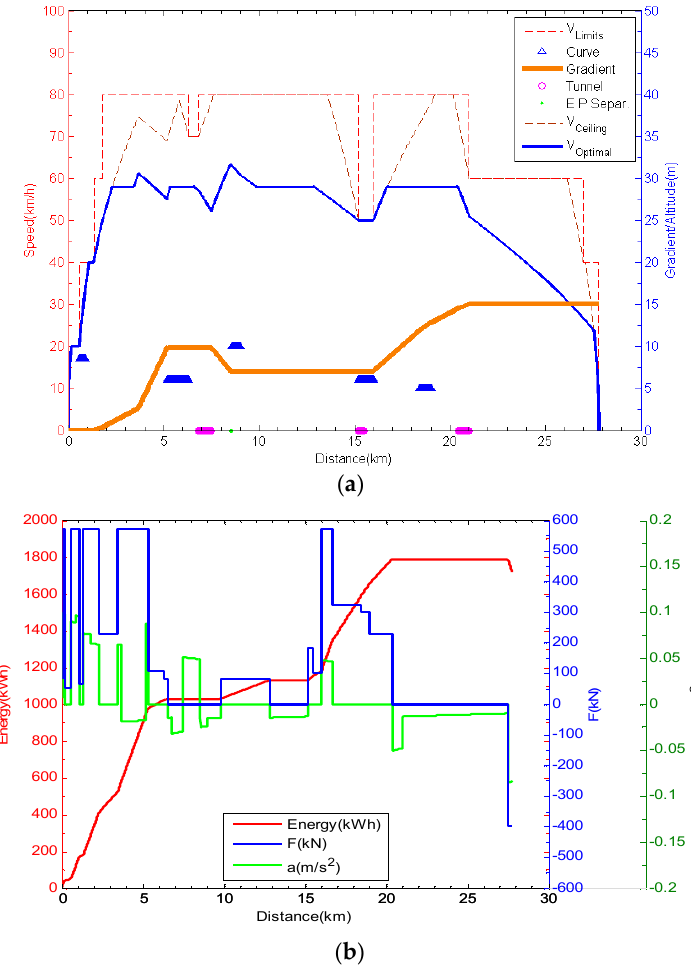
Figure 17. Simulation of speed profile programing in a test line with both steep uphill and downhill sections. ( a ) Diagram of the optimized speed profile; ( b ) Acceleration, traction force, and energy consumption of ( a ).